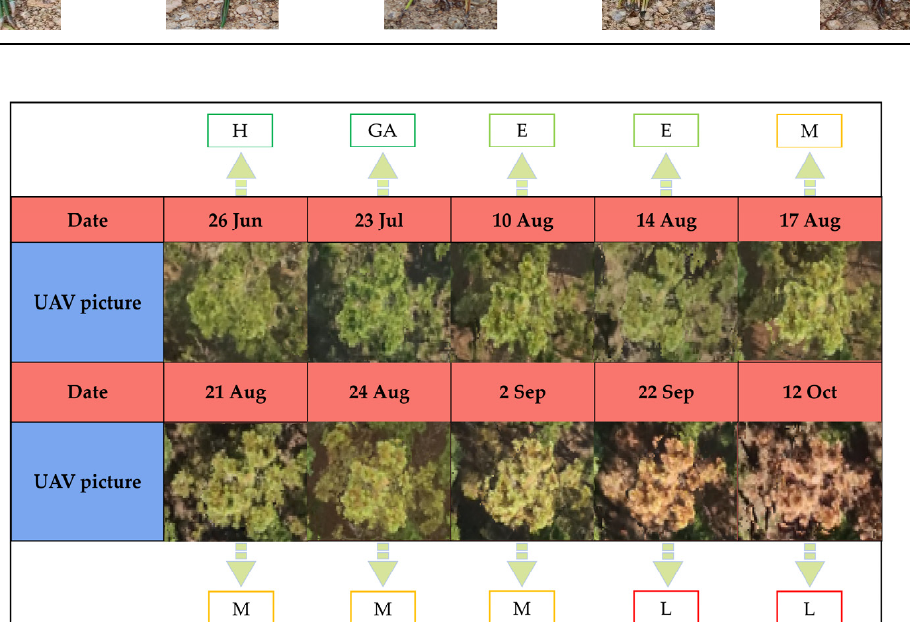
Figure 3. Temporal changes in the canopy color of infected trees. The text above the date of the picture indicates different stages of infection, and H, GA, E, M, and L represent healthy, green attack, early, middle, and late, respectively.